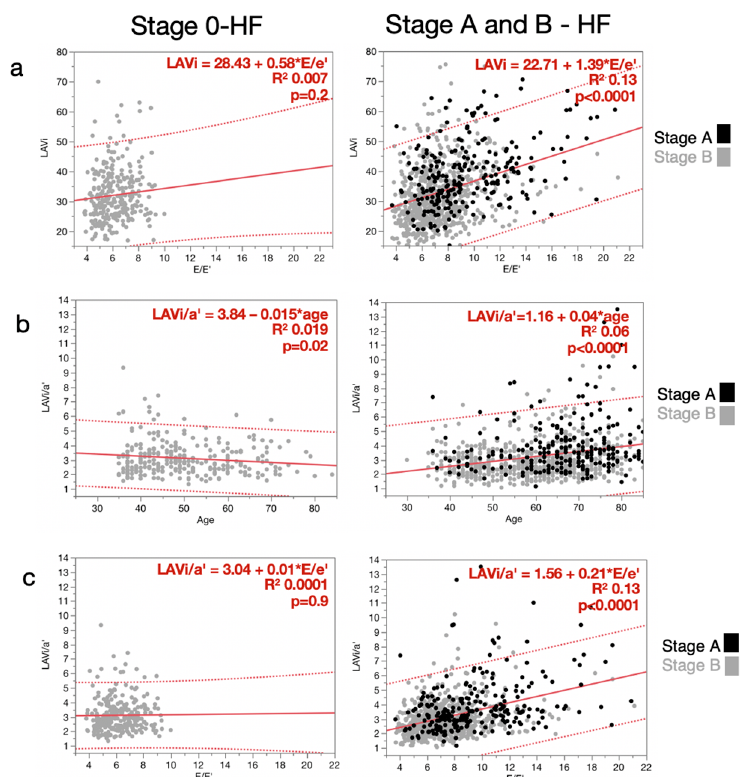
Figure 2. Relationships between LAVi and E/e’ ( a ) LAVi/a’ and age ( b ) and LAVi/a’ and E/e’ ( c ) for healthy individuals (Stage 0 Heart Failure, left), and patients at risk of heart failure (Stage A and B Heart Failure, right). Abbreviations: LAVi, Left Atrial Volume index; E/e’, ratio between E wave velocity and early diastolic velocity of the mitral annulus; LAVi/a’, ratio between Left Atrial Volume index and peak late annular diastolic velocity.